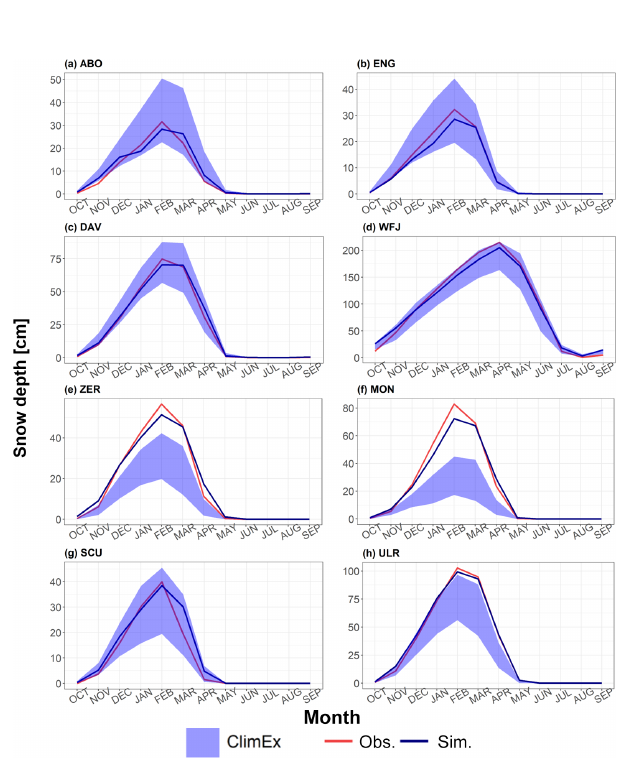
Figure 4. Long-term monthly mean snow depth for observations (obs), simulations driven by meteorological observations (sim) and the ensemble spread of simulations driven by the ClimEx LE for the period 1984 to 2009. See Table 1 for the abbreviations of case